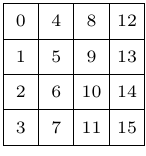
Figure 5: Bytes numbering in AES